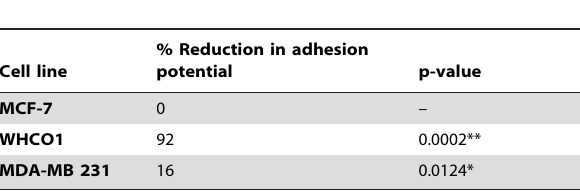
Table 2. IgG1-iS18 reduces adhesion potential of breast and oesophageal cancer